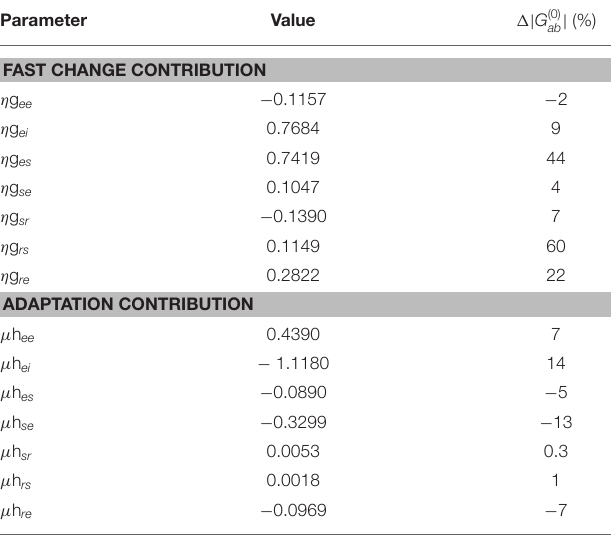
TABLE 2 | Characteristic fast and slow gain response parameters and their percentage change relative to the static baseline parameters G (0) ab (which are